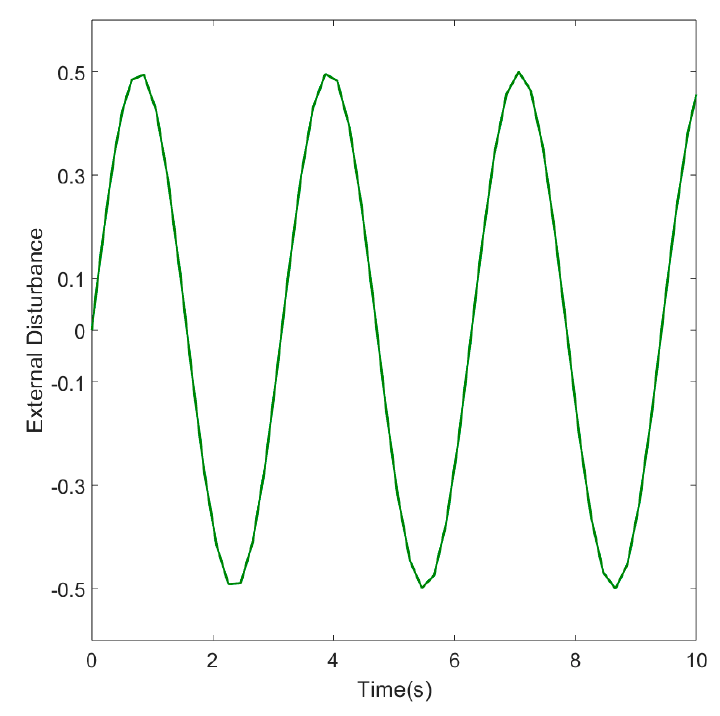
Figure 3. Responses of external disturbance.